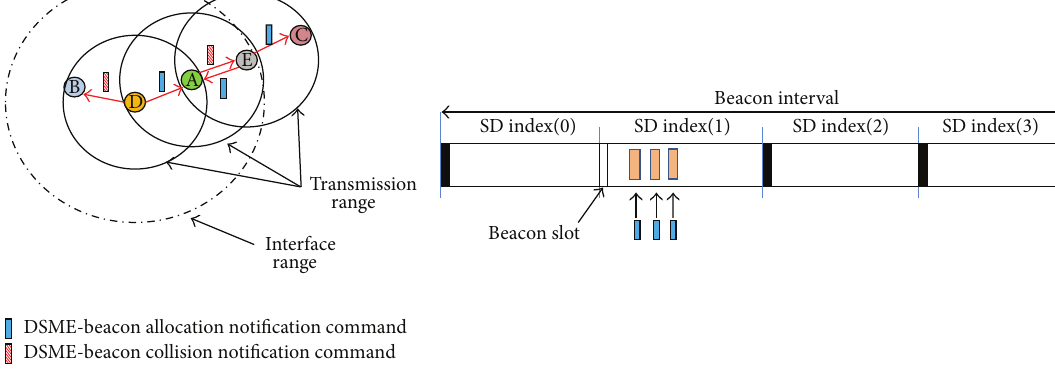
Figure 1: An example of collision avoidance during SD slot allocation in IEEE 802.15.4e